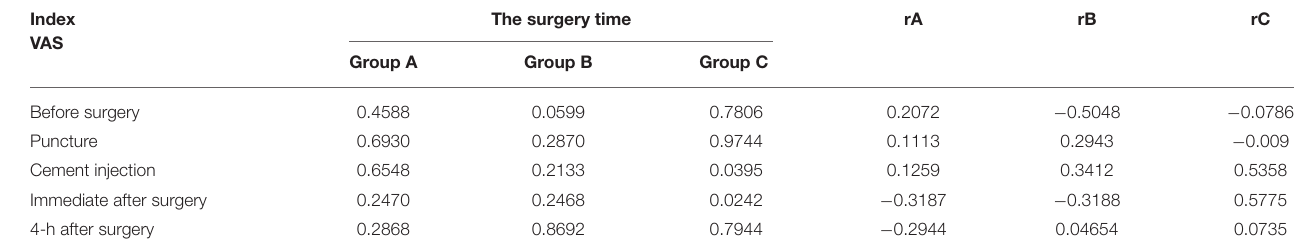
The surgery time